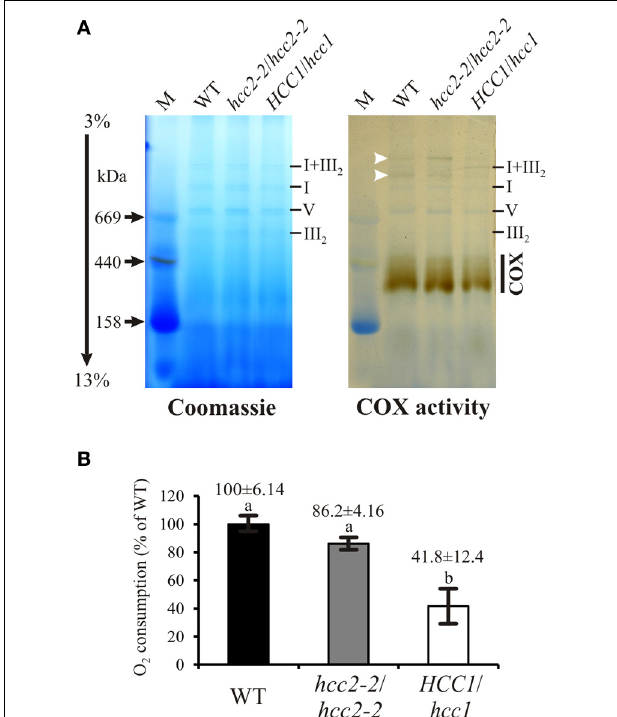
FIGURE 5 | COX activity analysis in the WT, hcc2 KO and hemizygous HCC1/hcc1 mutants. (A) Mitochondria (150 μ g each) from WT and mutant etiolated seedlings were solubilized using digitonin. The protein complexes were separated in a 3–13% gradient gel by BN-PAGE (left panel). COX complex activity was visualized in the same gel (right panel) as described in Material and Methods. The positions of abundant respiratory chain complexes (III 2 , V, I, and I + III 2 ) were determined by comparison to the BN electrophoretic mobility analysis of Klodmann et al. (2011). The white arrowheads mark putative supercomplexes explained in the Results section. M, molecular weight marker. (B) COX activity in mitochondria was determined by measuring oxygen consumption with a Clark electrode after addition of reduced cytochrome c . Mean values derive from triplicate measurements of two independent mt preparations. Error bars indicate standard deviations. The mean WT activity ( = O 2 consumption of 24 μ mol L − 1 min − 1 ) was set to 100%. Different letters indicate means that are significantly different from each other ( p < 0 . 01; one-way analysis of variance; Tukey